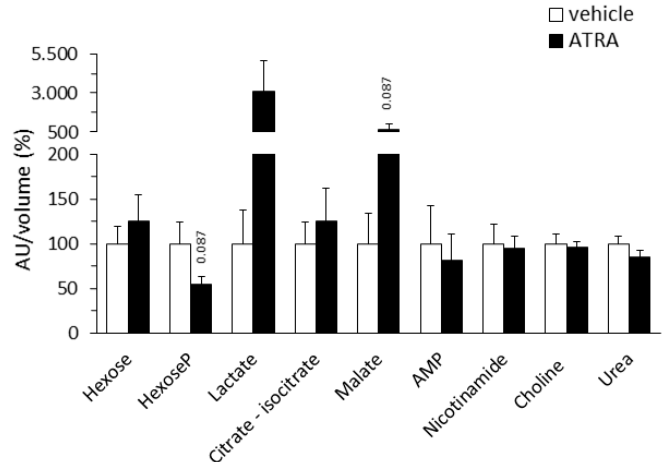
Figure 4. Relative plasma levels of the indicated compounds of intermediary metabolism in NMRI mice treated with all-trans retinoic acid (ATRA; 50 mg / kg body weight, subcutaneous injection) or the vehicle (olive oil) during 4 days. Metabolite peak area (as arbitrary units, AU) was normalized by the volume of plasma used in LC-MS / MS. Data are expressed as percentage with respect to the normalized value in the control group, which was set to 100%, and are the mean ± SEM of 11 animals per group. * Indicates significant di ff erence between the ATRA and the control group after Benjamini–Hochberg correction (observed p values in two-tailed Student’s t test are indicated when p < 0.1).